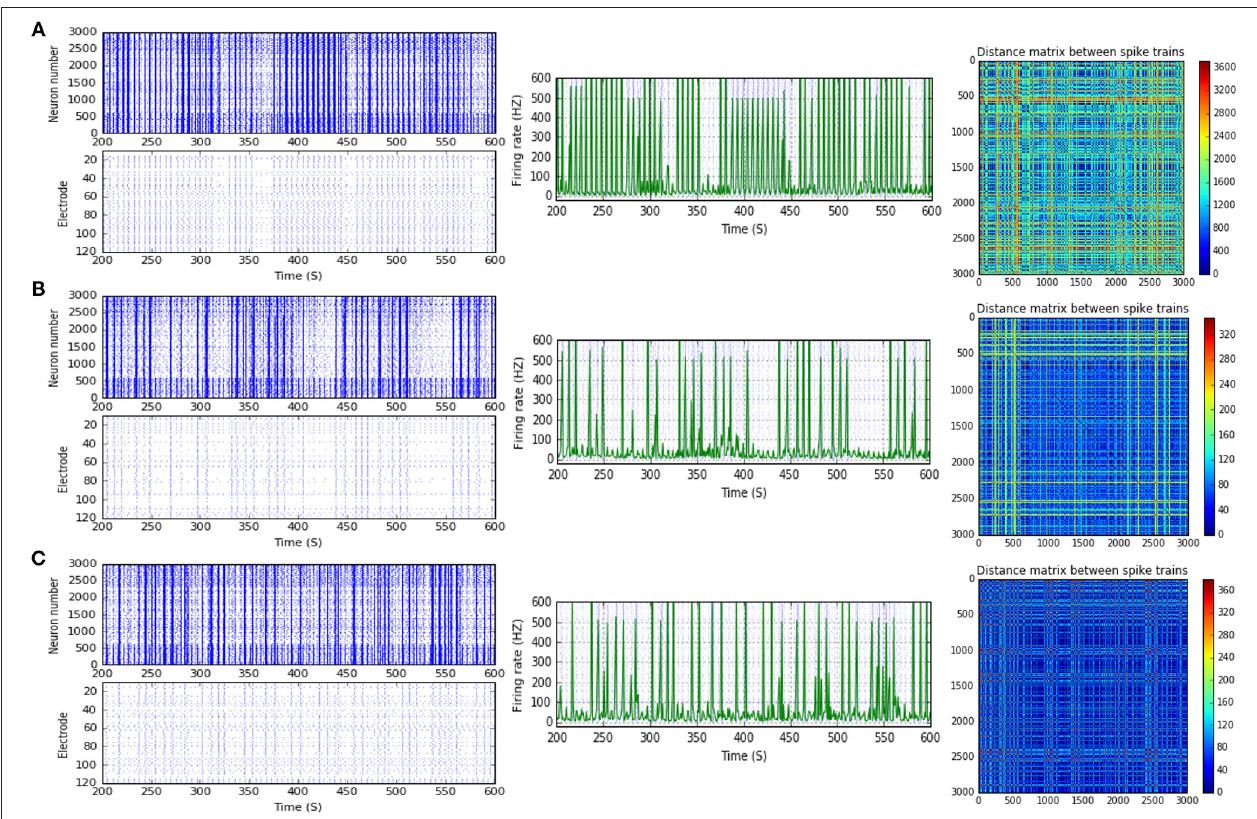
FIGURE 11 | Selected elicited firing response activity in the immature network scenario (B-2) before and after implementing STD1 and STD2 (when IF the range of high gamma). (A) refers to the condition without implementing dynamical synapses (control) while (B,C) refer to that after implementing depressing synapses (STD1 and STD2, respectively). The first two figures of each panel refer to monitoring the pattern of firing activity in time windows from 200 to 600 seconds(s). Heat maps of each panel represent modulation changes in spike distance matrix of the network scenario (B-2) before and after implementing STD1 and STD2. The simulation time for heat maps of the spike distance is equal to